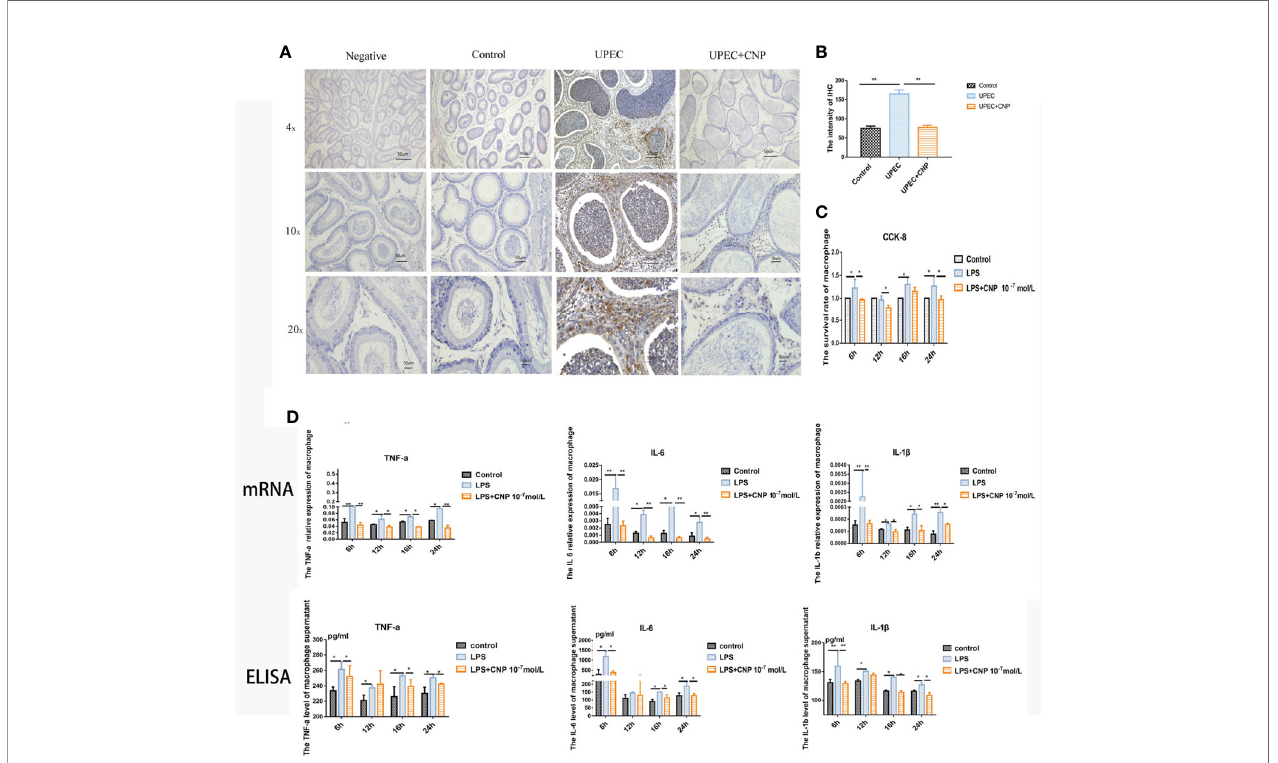
FIGURE 4 | CNP downregulates pro-in fl ammatory factors by affecting the in fi ltration and proliferation of macrophages. (A) IHC to detect macrophages in caput epididymis. (B) Histogram showed the degree of macrophage in fi ltration. (C) CCK-8 assay of the proliferative activity of in fl ammatory macrophages. (D) mRNA levels and concentrations of IL-6 , TNF- a , and IL-1 b . The data shown are representative of multiple experiments (mean ± SD, n = 3, *P < 0.05, **P <